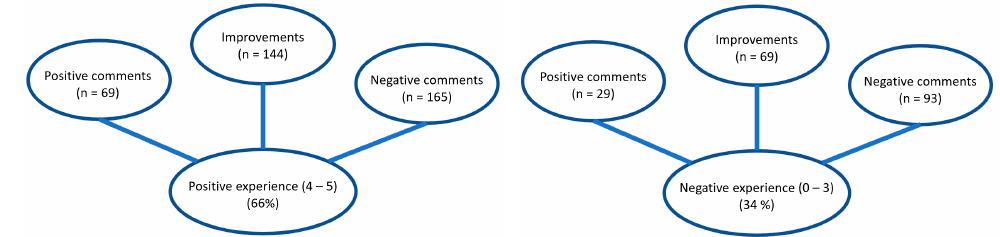
Figure 4. A graphic illustration of public response distributions between positive and neutral or negative experience groups, subdivided into sub-categorized comments by percentages of positive comments, improvement recommendations and negative comments.